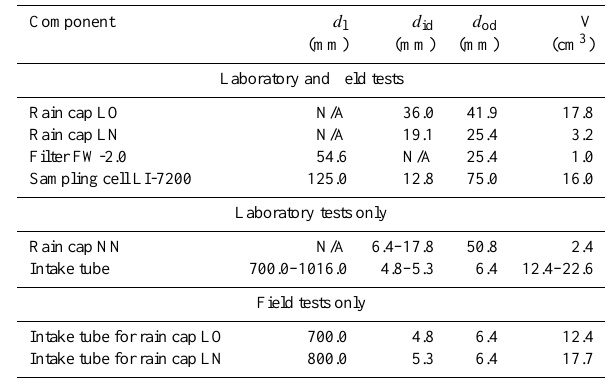
Table 3. Components tested in detail in the laboratory and field experiments including LI-COR old (LO), LI-COR new (LN) and NEON new (NN) rain caps, and the Swagelok FW-2.0 filter (Ta- ble 2 provides detailed specifications). Key characteristics include length ( d l ), inner diameter ( d id ), outer diameter ( d od ) and volume ( V ), some of which are not applicable or available (N/A) where in- dicated. Only components and materials selected for this study are shown, and numerous alternatives are excluded. Cross combinations were also tested.